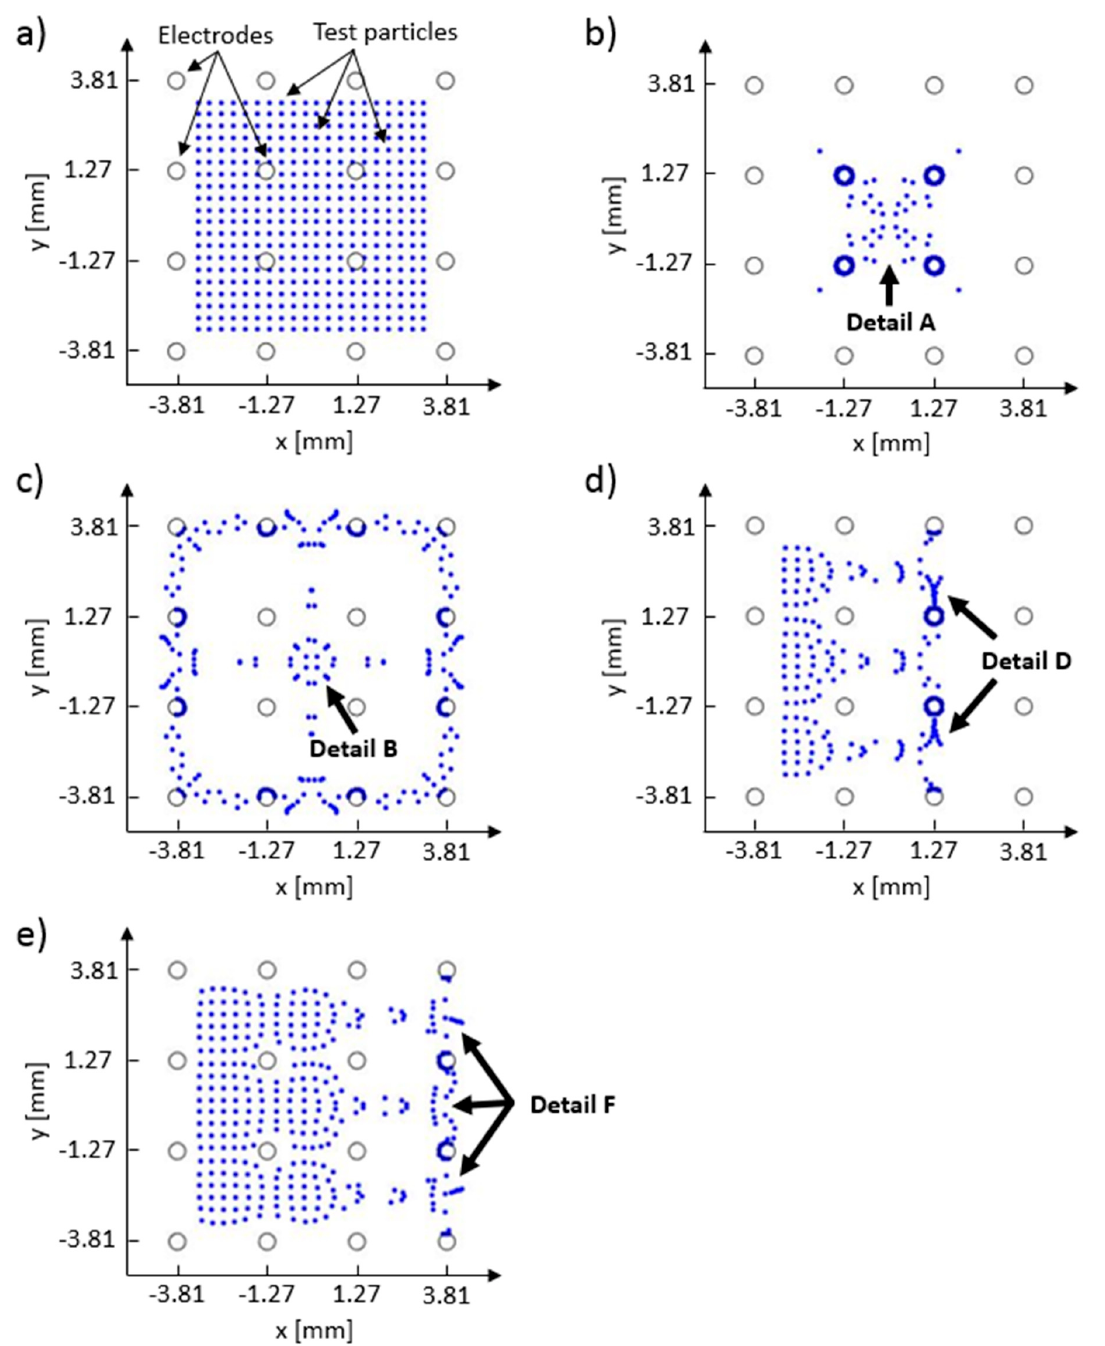
Figure 12. Test particle distributions in the built multiphysics 2D FEM model of the EP µ AM process. ( a ) Initial test particle positions for all FEM test runs; ( b ) test particle positions at the end of the application of focusing, control scheme A; ( c ) test particle positions at the end of application of the defocusing, control scheme B; ( d ) test particle positions at the end of translation to the third array column, control scheme C; ( e ) test particle positions at the end of translation to the fourth array column, control scheme D. Large gray circles represent electrode surface positions.